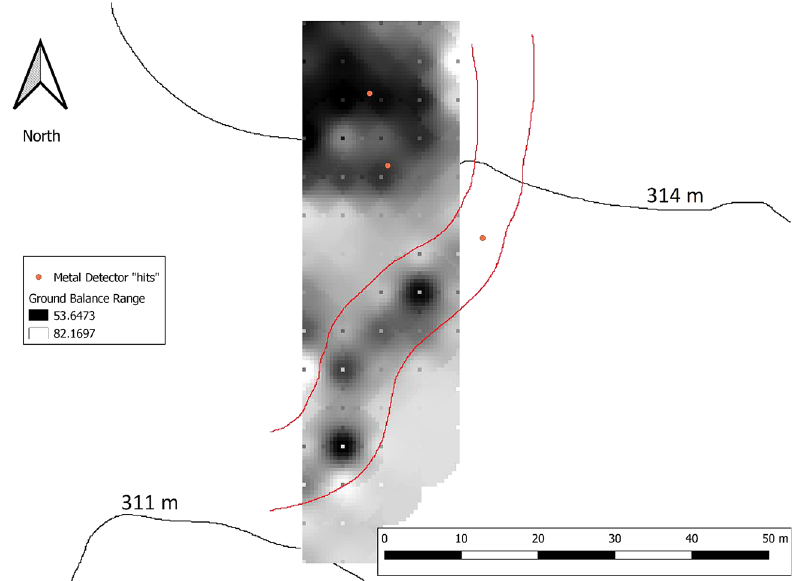
Figure 11: Interpolation map of the Matney Site, with locations of positive auger tests. Note the change in readings as the elevation decreases, and the clear spike of readings following the compacted dirt road running through the survey area drawn in